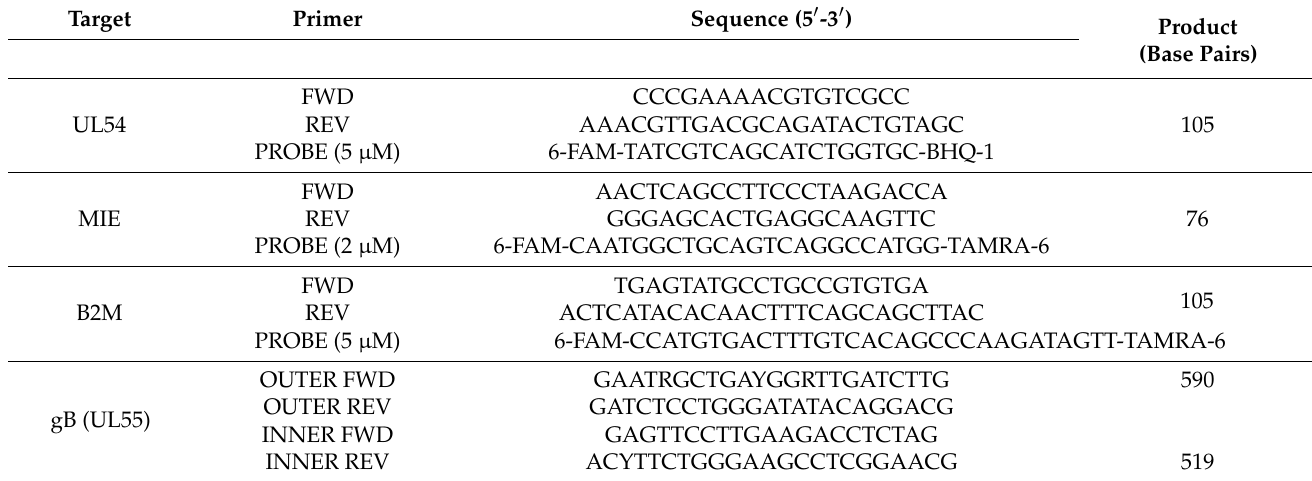
Table 1. Primer and probe sequences used to detect HCMV DNA by qPCR or nested PCR.